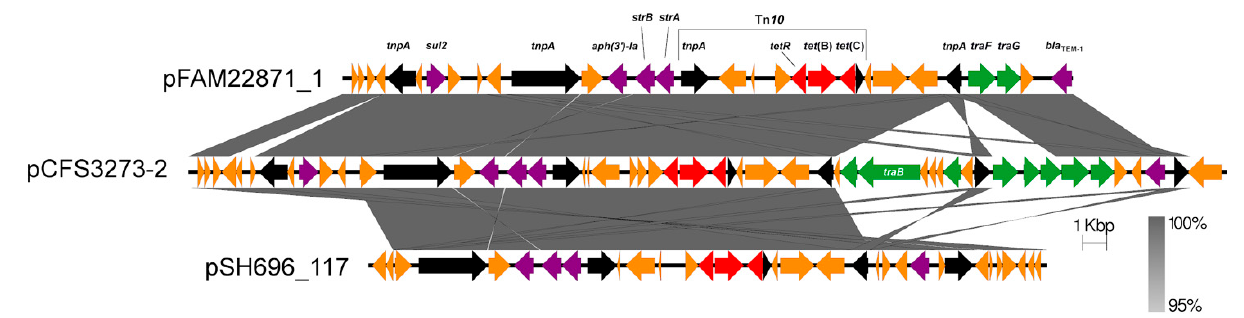
Figure 5. Complex AMR region between plasmids pFAM22871_1, pCFS3273-2, and pSH696_117. High conservation of a complex antimicrobial resistance gene region with the presence of Tn 10 in plasmids pCFS3272-2. Extensive deletion of the tra region is observed in plasmid pFAM22871_1. Colour scheme: antimicrobial resistance genes (purple), tetracycline resistance genes (red), transposons and insertion elements (black), and genes of interest (green). Other genes are represented in orange.